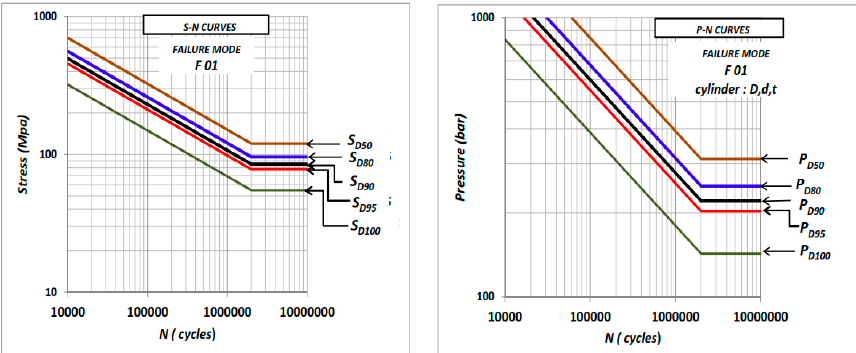
Figure 6. Typical ( left ) S–N curves and ( right ) P–N curves for specific hydrauklic cylinder geometry for this same failure mode (F-01).